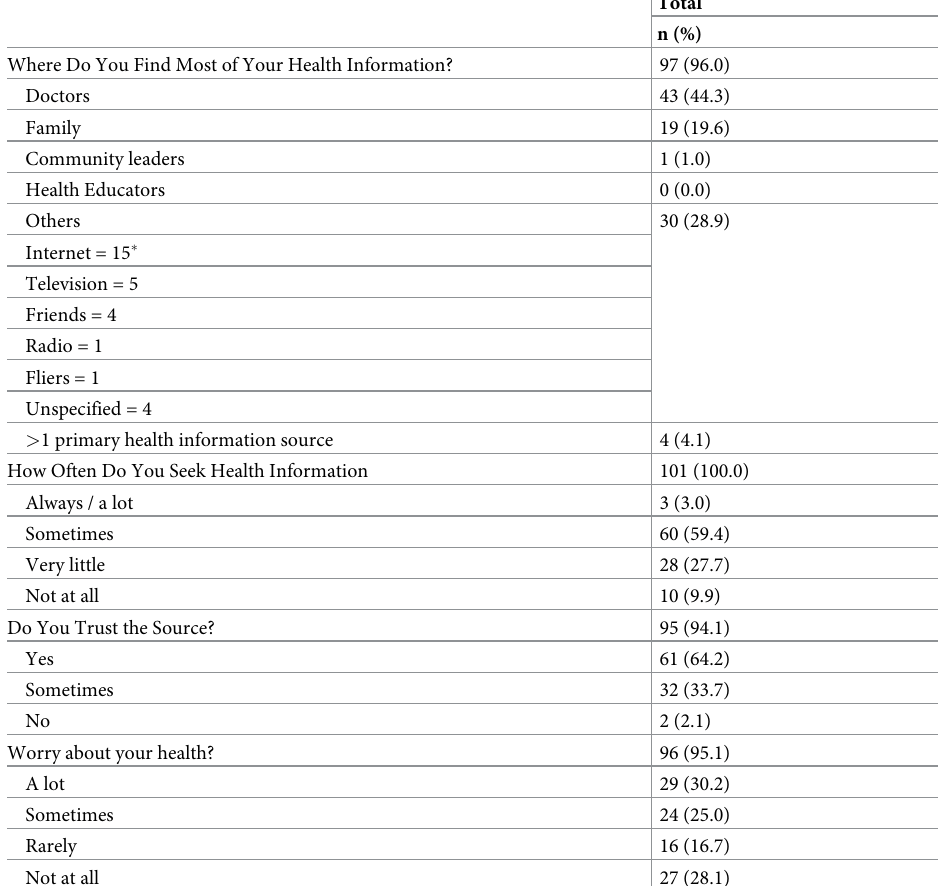
Table 2. Health seeking behavior of Congolese building bridges program participants, Fort Worth, Texas, January 2018 –March 2020 (n = 101).